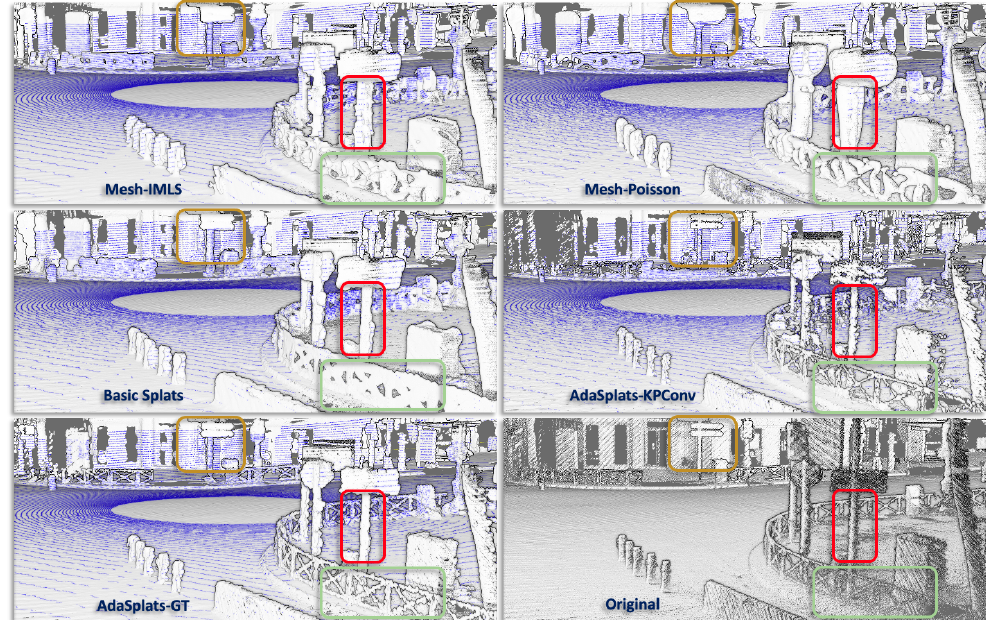
Figure 9. Comparison of simulated LiDAR data using different reconstruction and modeling methods on PC3D-Paris. The top row shows the simulation in meshed IMLS (left) and Poisson (right). The mid- dle row shows the simulation with Basic Splats (left) and AdaSplats-KPConv (right). The bottom row shows the simulation with AdaSplats-GT (left) and original point cloud